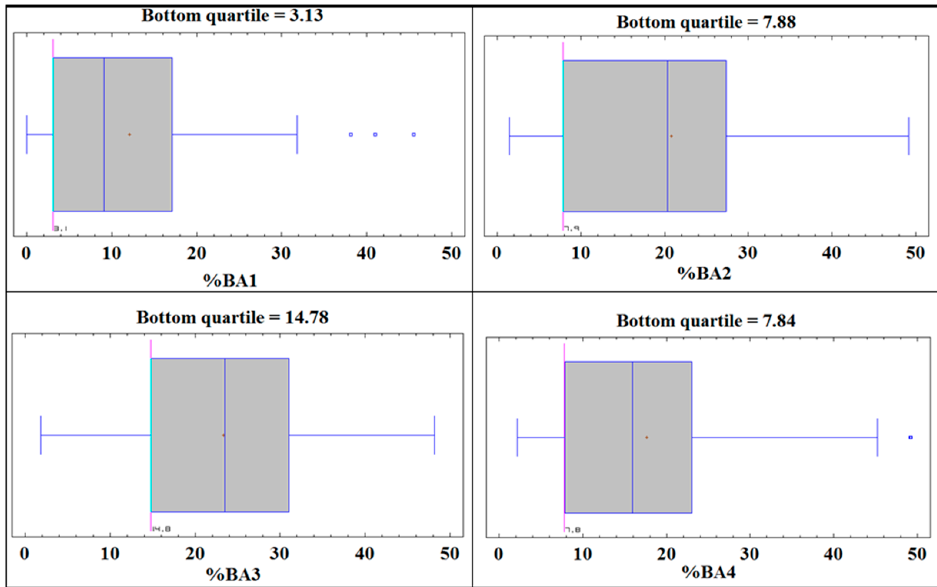
Figure 2. Box-and-whisker plot for the frequency analysis for each % BA i variable.